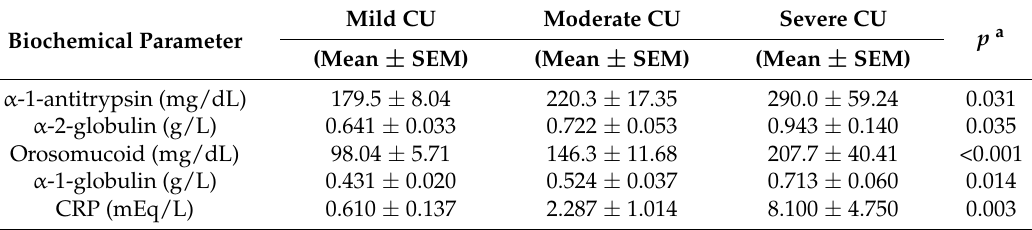
Table 4. Plasma inflammatory biomarkers in UC Patients as a function of